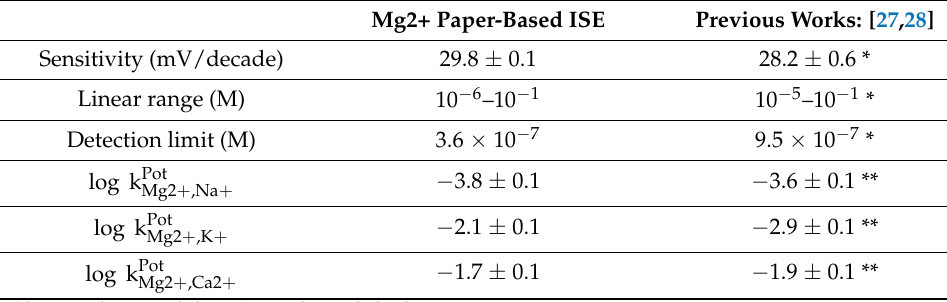
Figure 2. Typical potentiometric time traces for paper-based ( A ) Ca 2+ and ( B ) Mg 2+ ISEs. The inset shows the corresponding calibration curves (error bars represents the measurements of three sensors, N = 3). Table 1. Comparison of the analytical parameters of the paper-based Mg-ISE (N = 3).